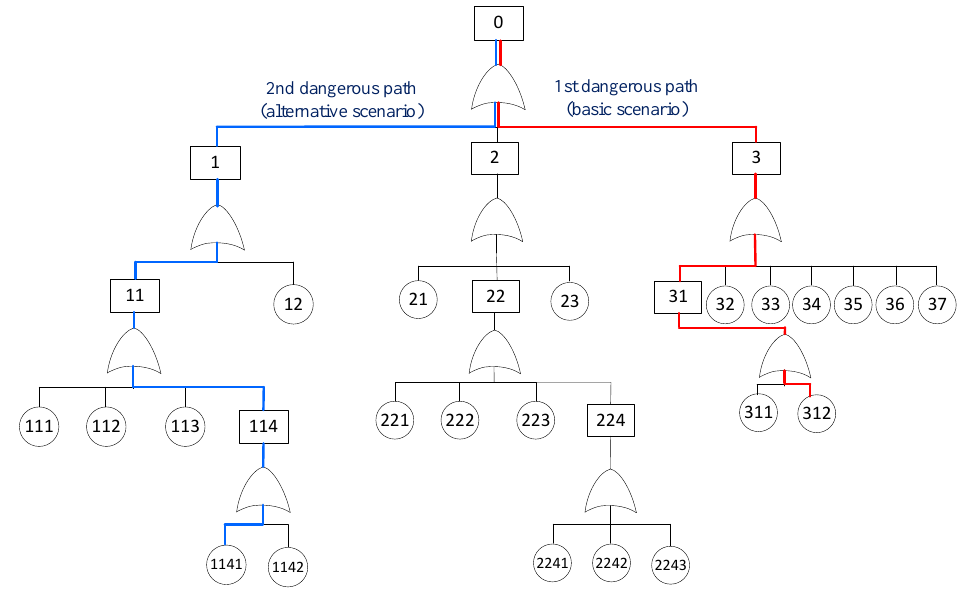
Figure 5. The most dangerous paths of the risk situation